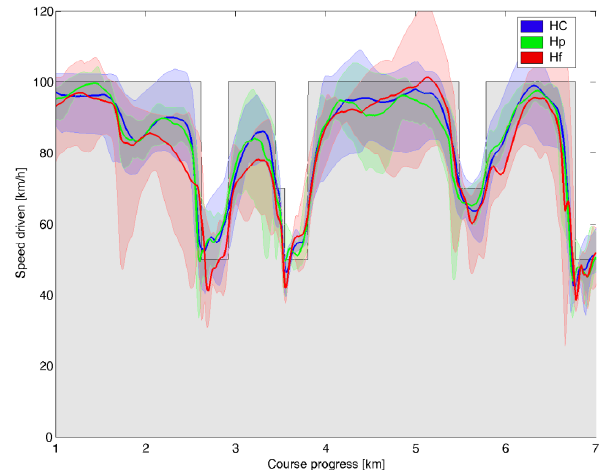
Figure 9 . Speed driven during the first seven kilometers. The line indicates the average speed in the group, the boundaries of the colored area show the minimum and maximum speed. HC: control group, Hp: HVFD patients who passed the driv- ing test, Hf: HVFD patients who failed the driving